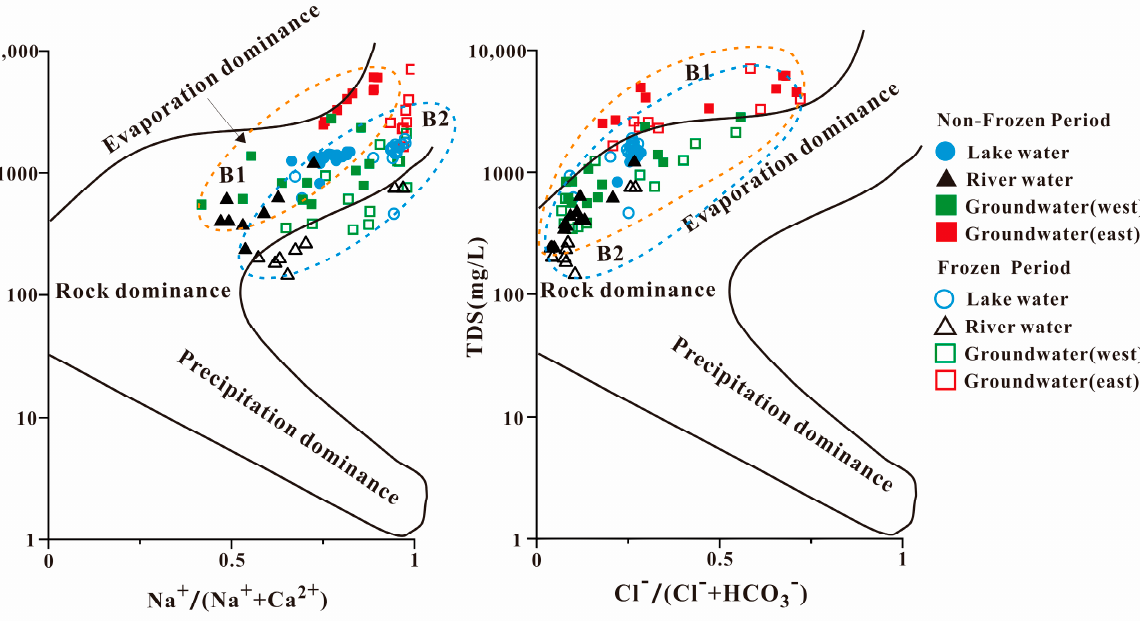
Figure 3. Gibbs diagram of the main water chemical ions in different seasons in each water body in the study area. B1: non-frozen period; B2: frozen period.